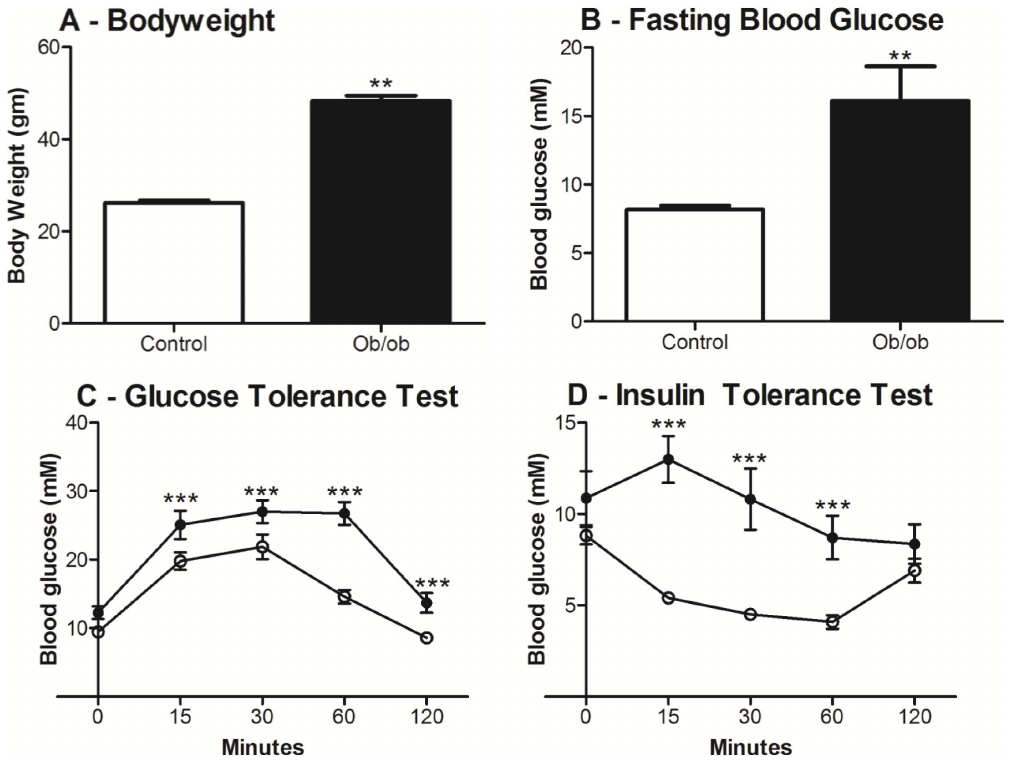
Figure 1. Body weight, fasting blood glucose, glucose tolerance test (GTT) and insulin tolerance test (ITT) of ten-week old ob/ob and lean mice. Ob/ob mice were significantly heavier (A) with significantly higher fasting blood glucose (B) than lean mice. GTT (C) and ITT (D) were performed after 12–13 hours of fasting. Compared to lean mice, ob/ob mice displayed glucose intolerance and insulin resistance. Data are shown as mean 6 SEM (n=9 mice/group; ob/ob , closed bar/closed circle; lean mice, open bar/open circle). Analyses were performed using Students t-tests for body weight and fasting blood glucose; and two-way ANOVA for GTT and ITT. **, P , 0.01; ***, P , 0.001.